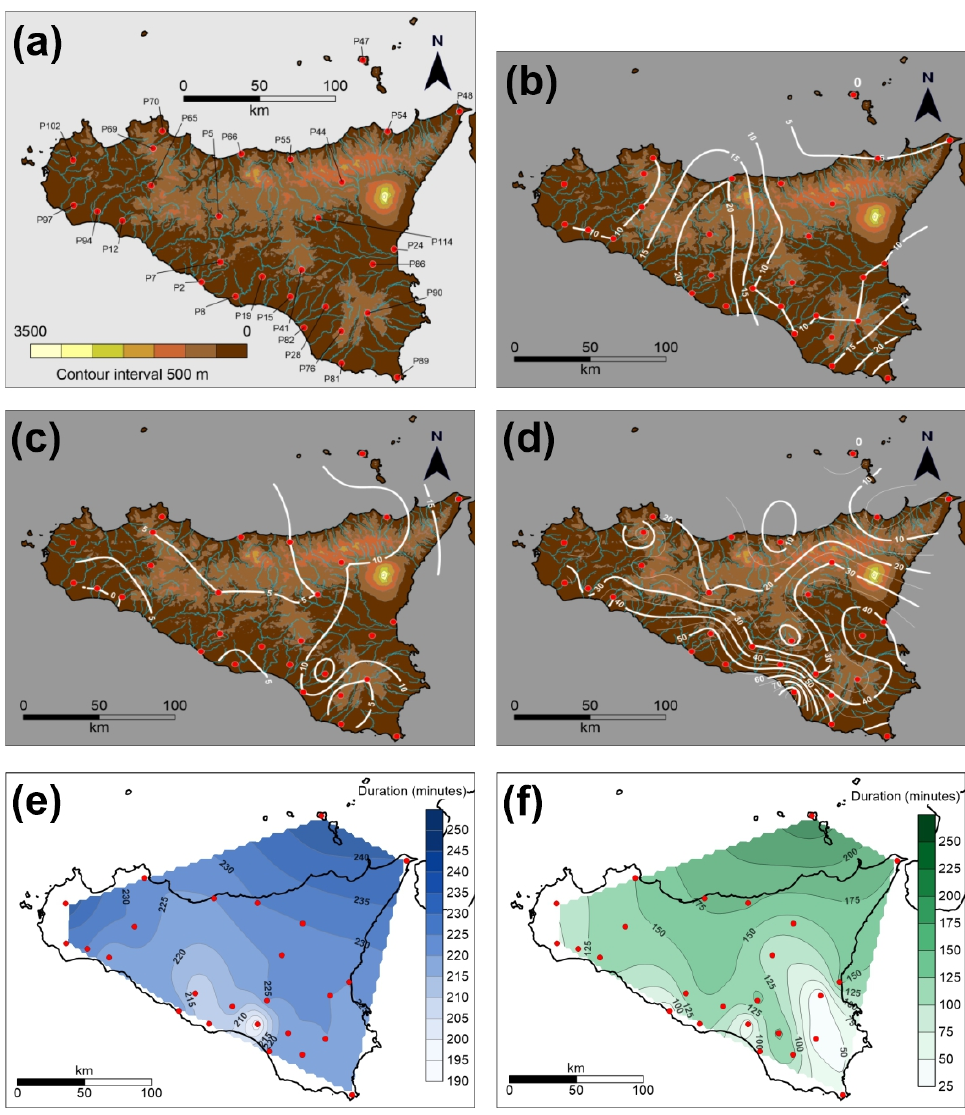
Figure 6. ( a ) Colour relief map of Sicily, with location of SIAS network stations (red circles) and main river network (light blue lines); ( b ) delay time (minutes) of the first atmospheric pressure anomaly onset (first passage of the shockwave along the short range); zero is the first detection time among the stations. See methods for details about the picking procedure. ( c ) Delay time (minutes) of the first atmospheric pressure anomaly onset (first passage of the shockwave along the long range); ( d ) delay time (minutes) of the first atmospheric pressure anomaly onset (second passage of the shockwave along the short range); ( e ) duration (minutes) of the instant atmospheric pressure anomaly (first passage, short and long ranges not discriminated); ( f ) duration (minutes) of the instant atmospheric pressure anomaly (second passage, short and long ranges not discriminated).